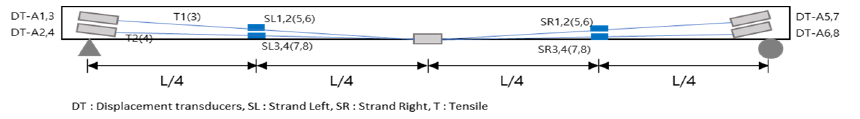
Figure 8. Positions of reinforcement gauges used for the NSM method.